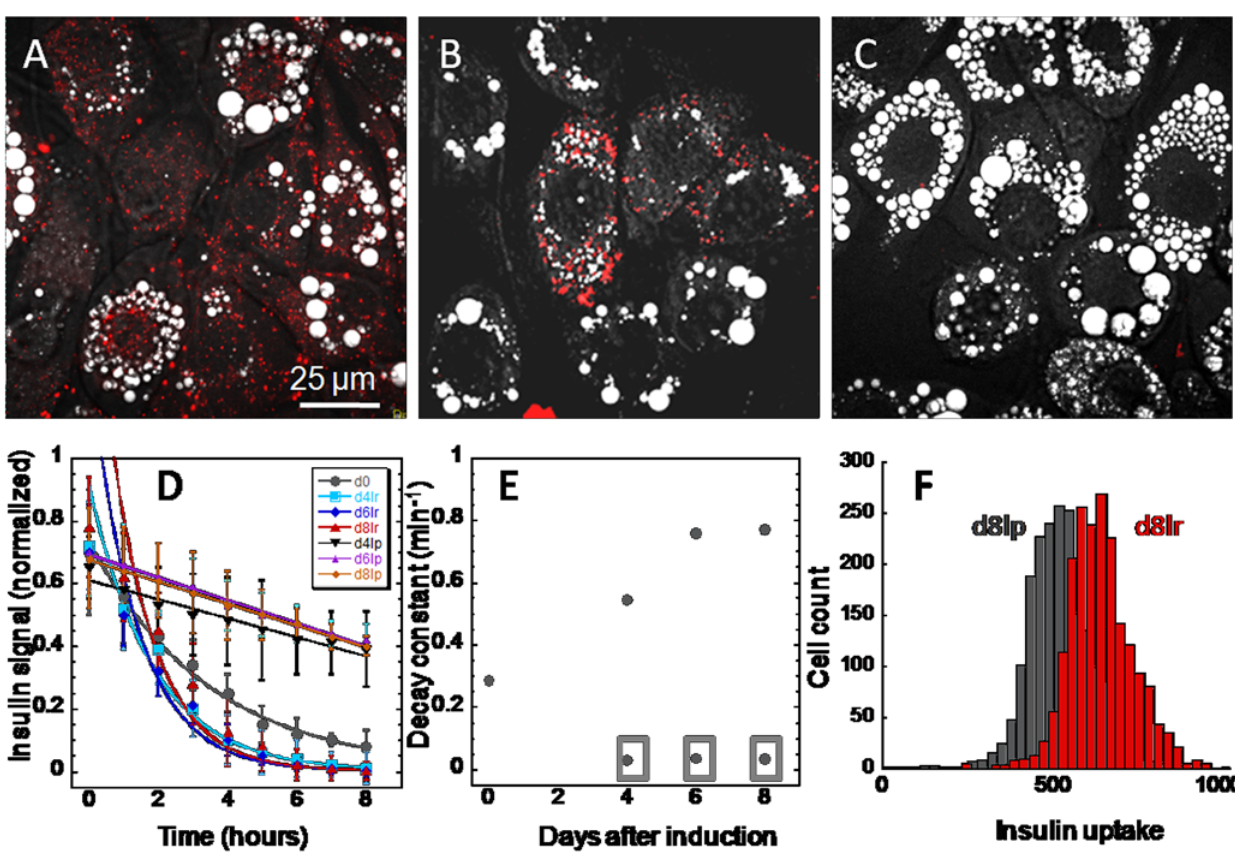
Figure 5. Increased insulin degradation rate in lipid-rich cells. ( A ) Insulin uptake in both lipid-rich and lipid-poor cells at 5 minutes after insulin-Cy3 addition. ( B ) Insulin signal degrades faster in cells with more lipid droplet accumulation at 4 hours after insulin-Cy3 addition. ( C ) Insulin signal is undetectable in lipid-rich cells at 6 hours after insulin-Cy3 addition. ( A–C ) Cells on day 6, or 2 days after removal of unlabeled insulin, are used. ( D ) Quantitative analysis of insulin signal degradation in representative cells at various days after induction. Error bars represent distribution of insulin signal across 20 representative cells analyzed. ( E ) Decay constant extracted from ( D ) is plotted as a function of time after induction. ( F ) Flow cytometry analysis shows increase in insulin uptake of lipid-rich cells (red) as compared to lipid-poor cells (grey) at day 8 after induction. Red: TPEF insulin-Cy3 signal. Grey: CARS lipid signal.